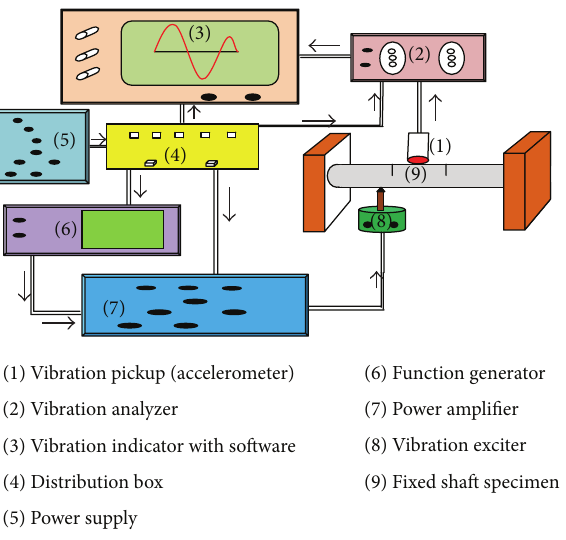
Figure 8: Experimental